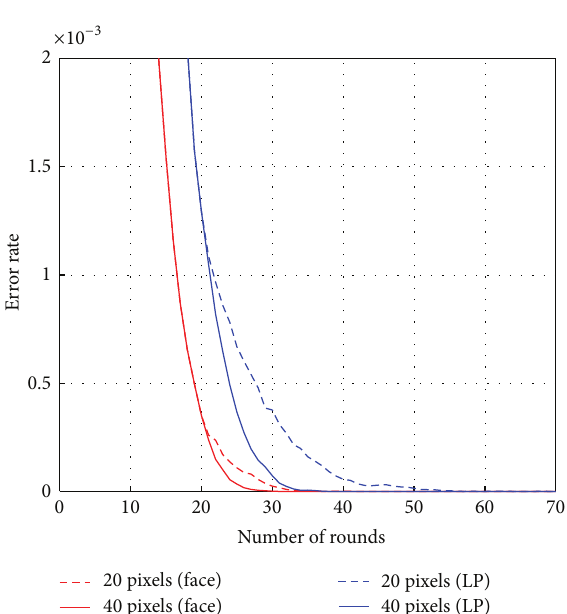
Figure 7: Training error according to the number of pixel locations.